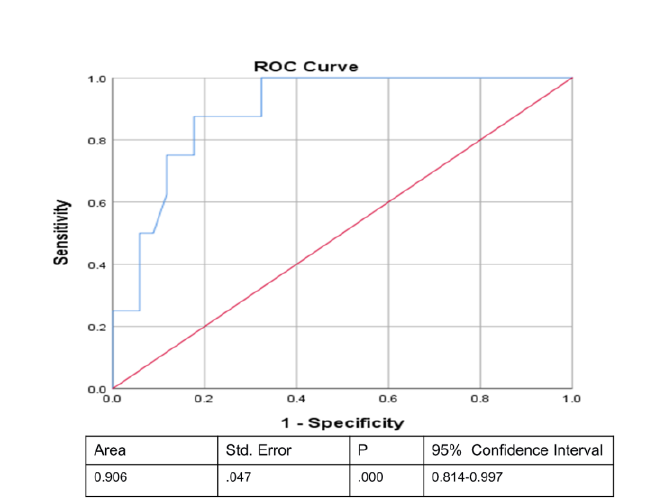
Figure 2 ROC curve of elasticity ratio